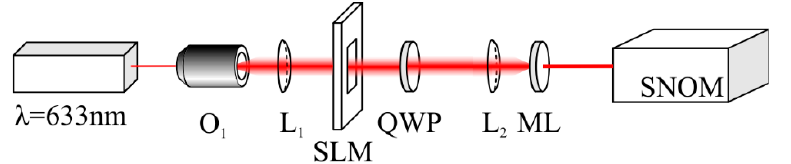
Figure 6. Experimental setup. Laser—Cobolt 06 MLD ( λ = 633 nm, 80 mW); O 1 —20× objective lens; SLM—spatial light modulator (Holoeye LC 2012, 1024 × 768 px); L 1 , L 2 —lenses (f 1 = 150 mm and f 2 = 10 mm), QWP—quarter-wave plate; SNOM—scanning near-field optical microscope (Ntegra Spectra).